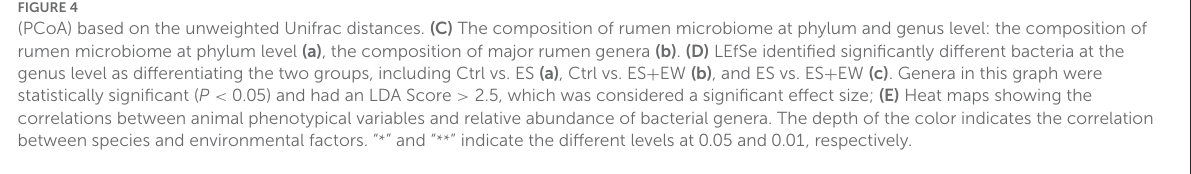
0.047), and Succinivibrio ( R = − 0.531, P = 0.034). The